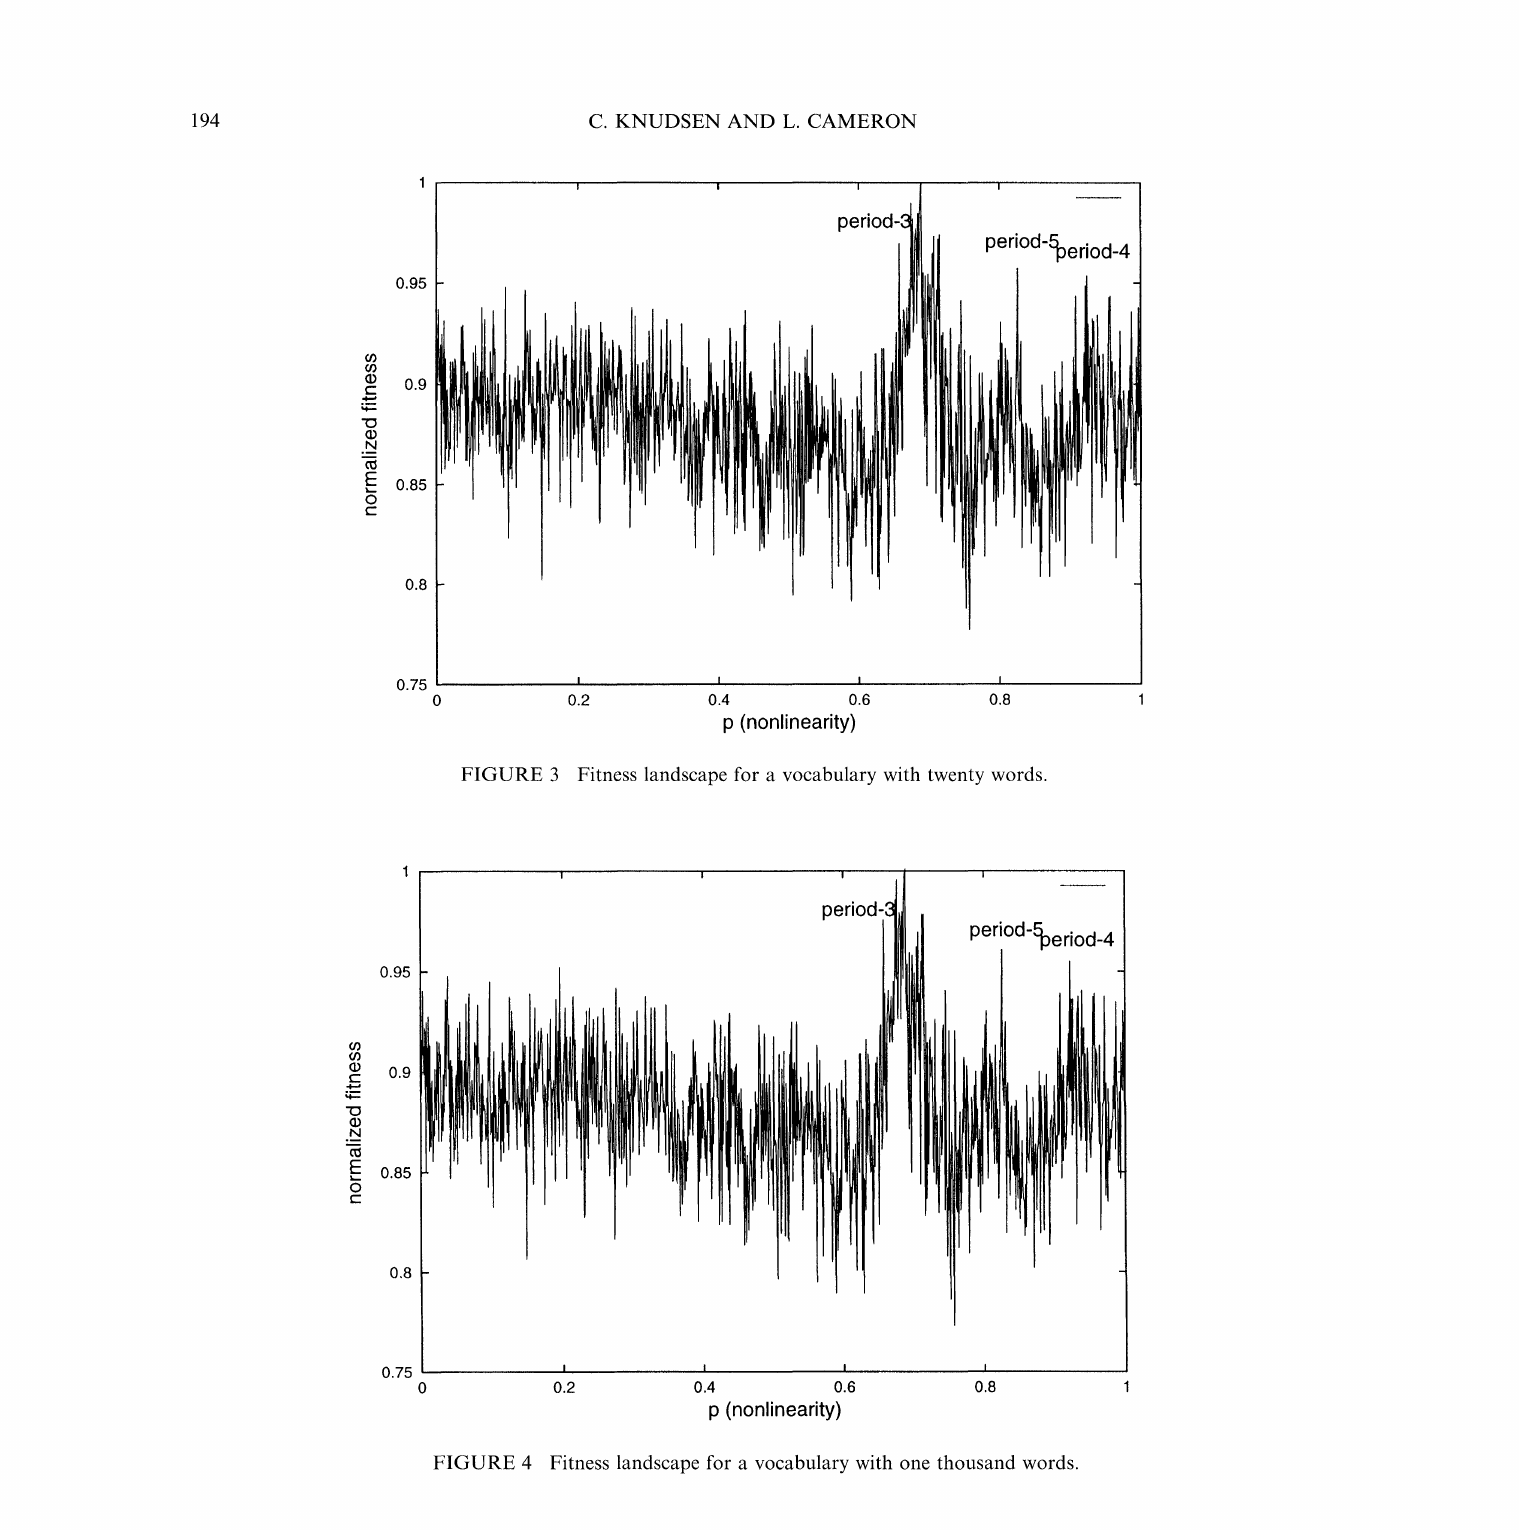
FIGURE 4 Fitness landscape for a vocabulary with one thousand